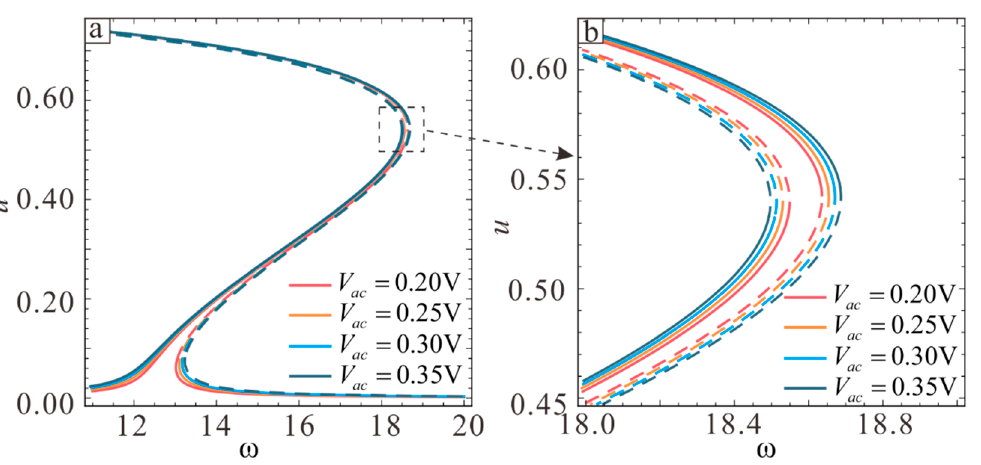
Figure 15. Influence of the AC voltage on the frequency response curve. The straight line shows the stable solution and the dotted line shows the unstable solution.